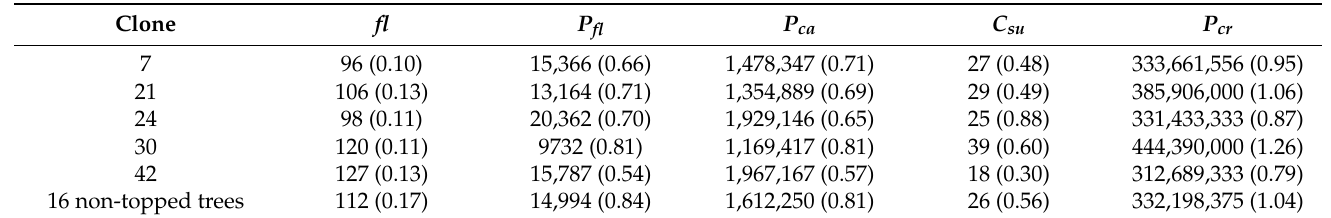
Table 5. Mean values for reproductive metrics and associated coefficients of variance (CV) of clones with non-topped trees in the seed plantation Wildberg for 2019–2021.